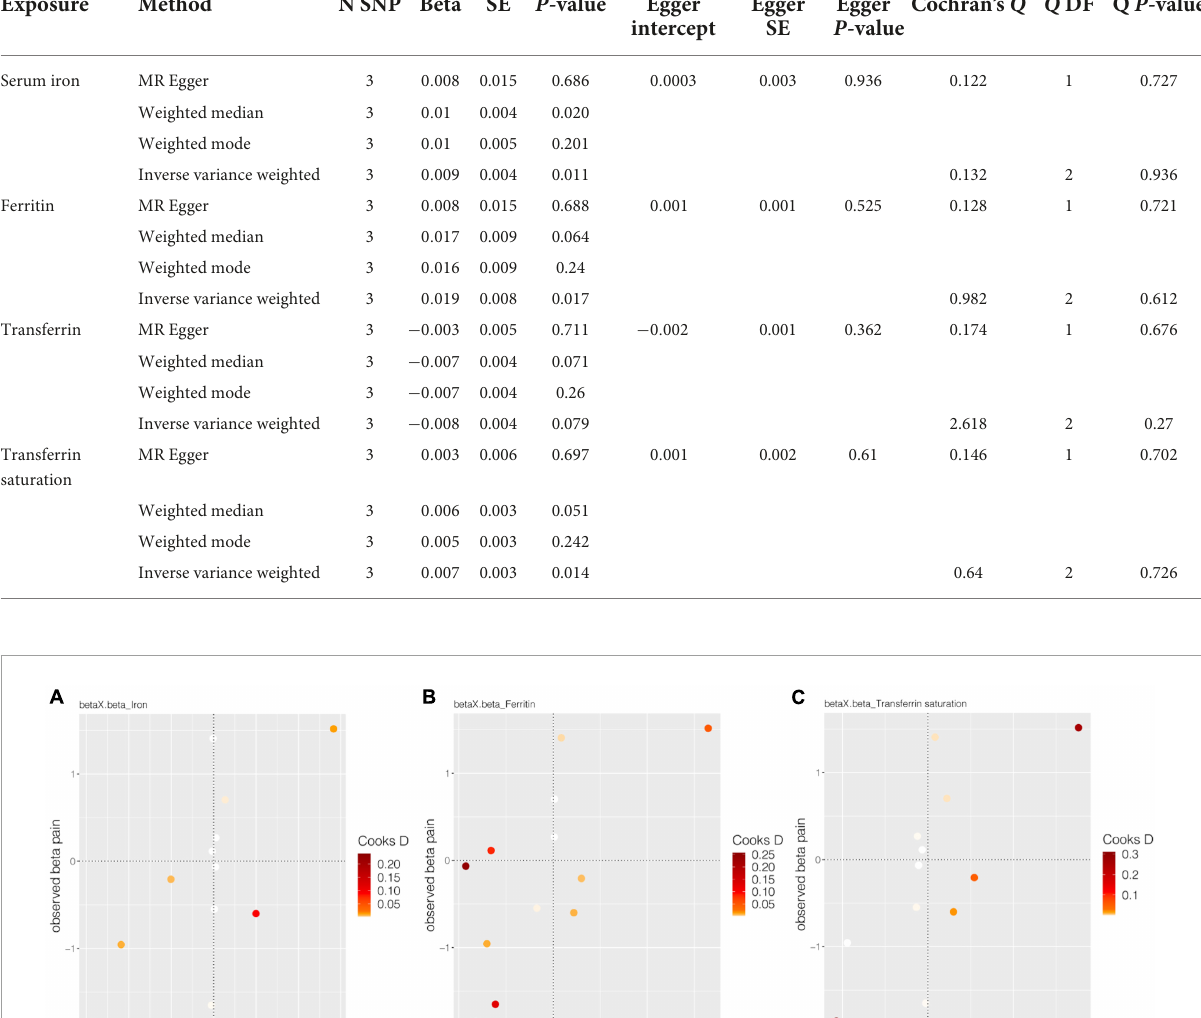
TABLE 4 Associations between genetically instrumented systemic iron status and back pain using the three SNPs associated with all four iron status biomarkers. Exposure